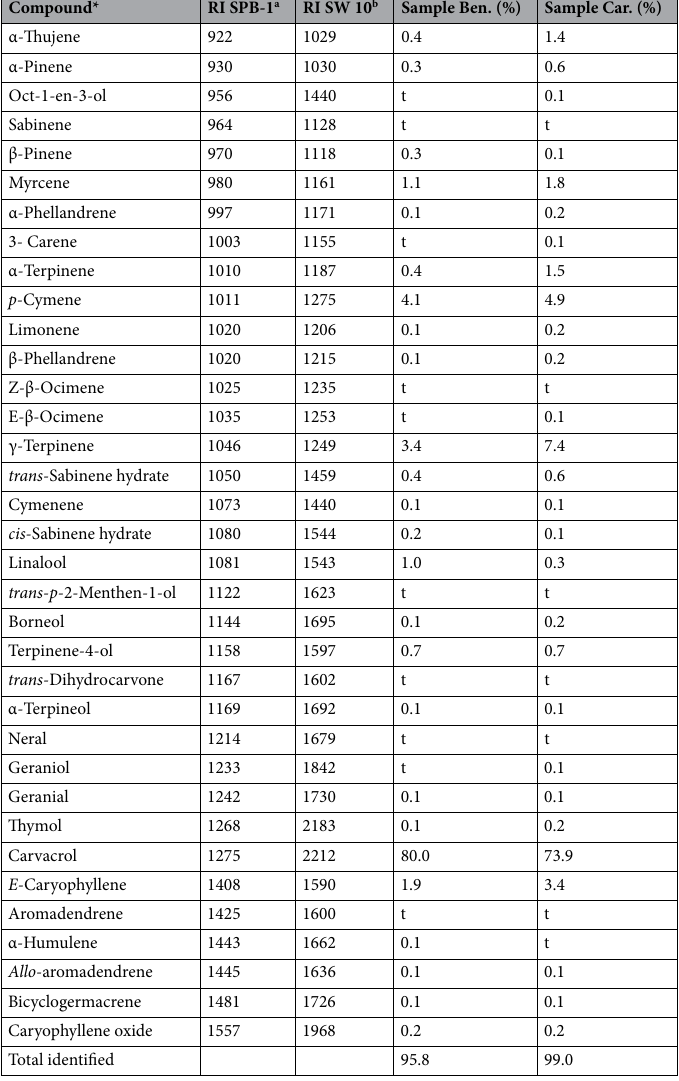
Table 1. Constituents of two samples of essential oils from Thymbra capitata . *Compounds listed in order of elution in the polydimethylsiloxane column (SPB-1 column). a RI SPB 1: GC retention indices relative to C9-C23 n-alkanes on the SPB-1 column. b RI SW 10: GC retention indices relative to C9-C23 n-alkanes on the Supelcowax-10 column. t = traces ≤ 0.05%.